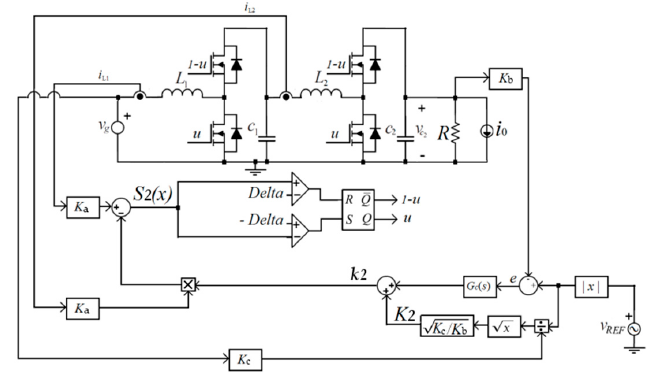
Figure 12. Self-oscillating control strategy.